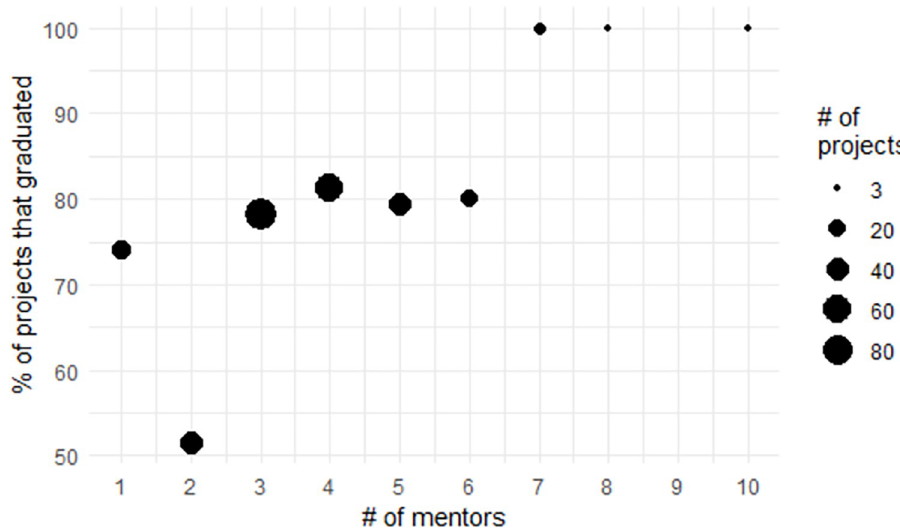
Fig 4. Graduation rate for projects with a certain number of